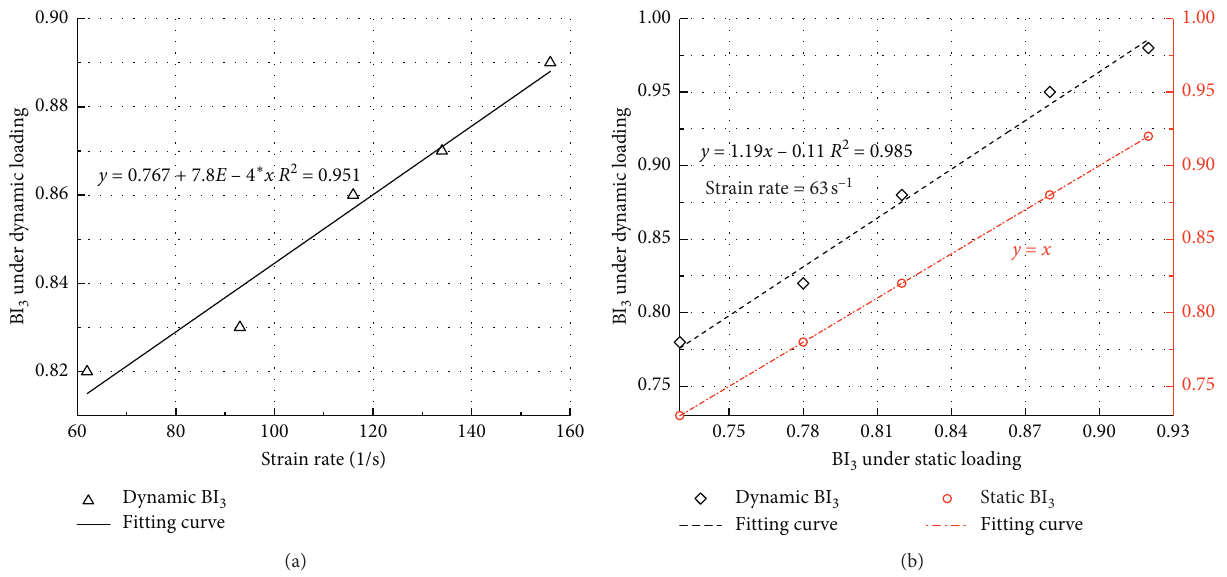
Figure 8: The variation in brittleness index BI